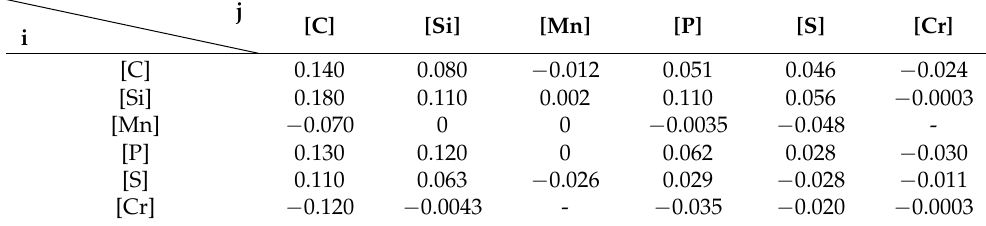
, of elements in molten steel. i